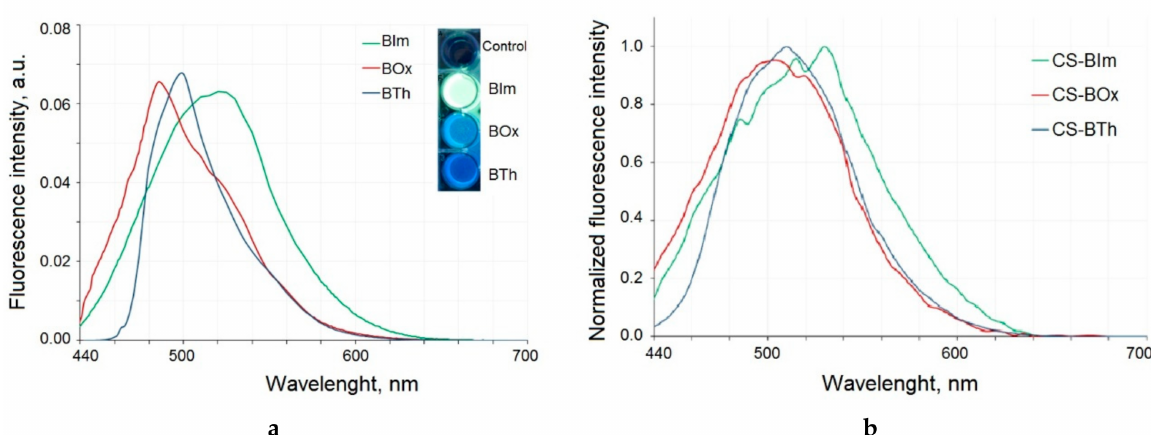
Figure 3. The emission spectra of the dyes excited with 425 nm light ( a ). Inset: the fluorescent properties of dyes excited with UV light (365 nm). Fluorescence spectra of modified chitosan samples ( b